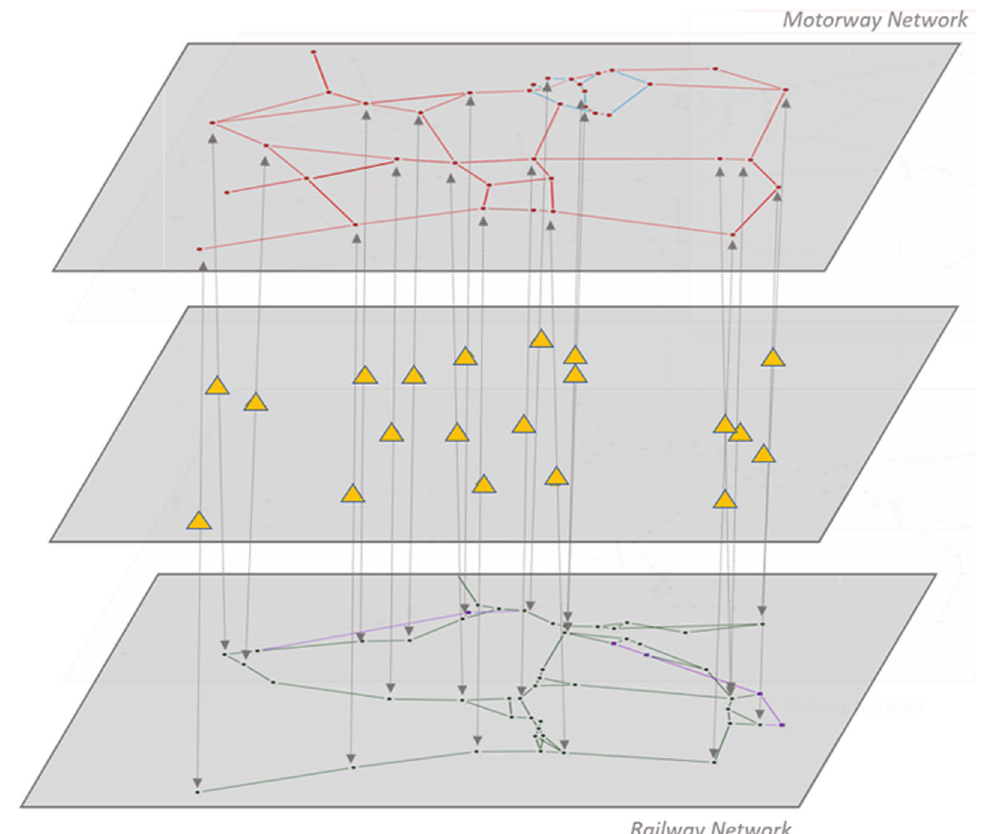
Fig. 6 Multi-layer network using railways, motorways, and artificial interchange